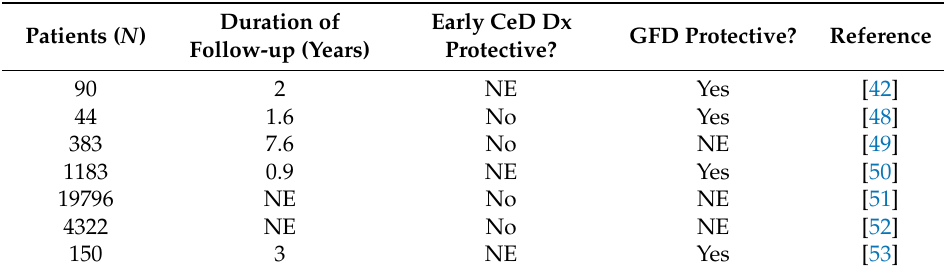
Table 3. Gluten exposure and occurrence of type 1 diabetes.